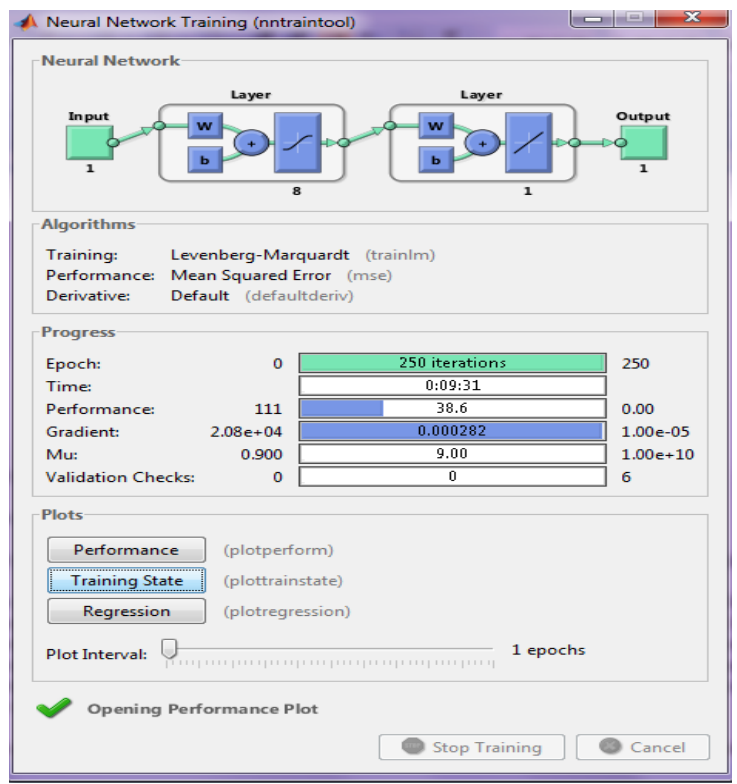
Figure A10. Neural network training.